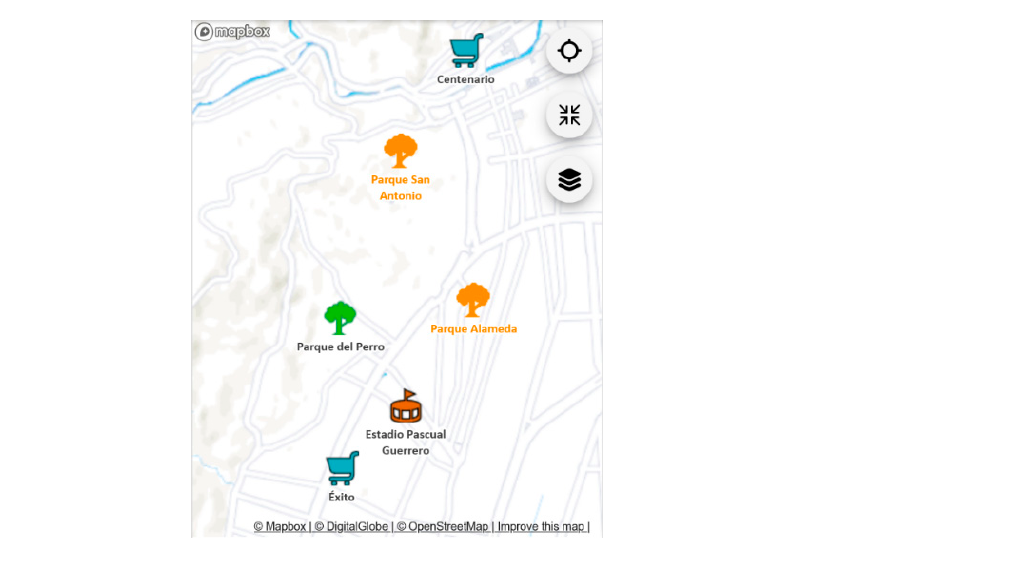
Figure 7. Map-reading task T3 (select multiple point features) with the Landmark map.